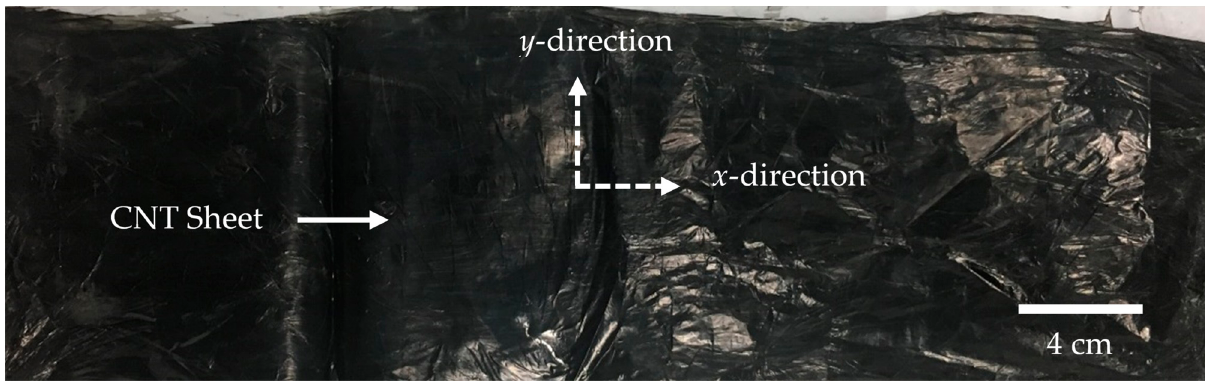
Figure 3. Synthesized carbon nanotube sheet from the floating catalyst method.